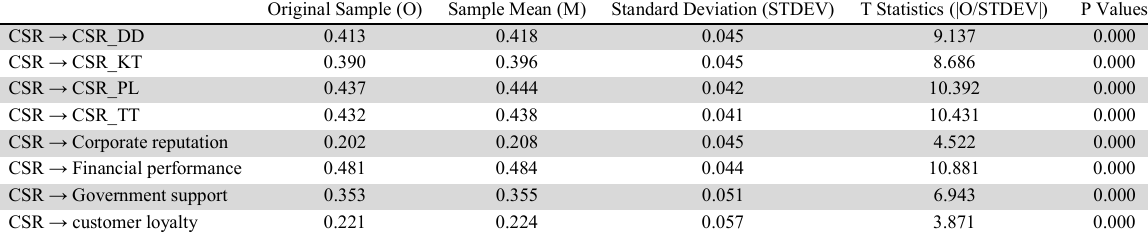
Hypothesis test